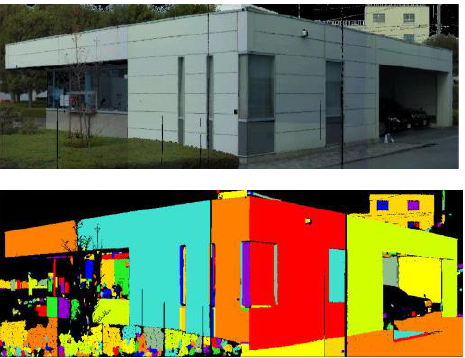
Figure 3. Image of Building A form viewpoint #1 and Segmentation result.